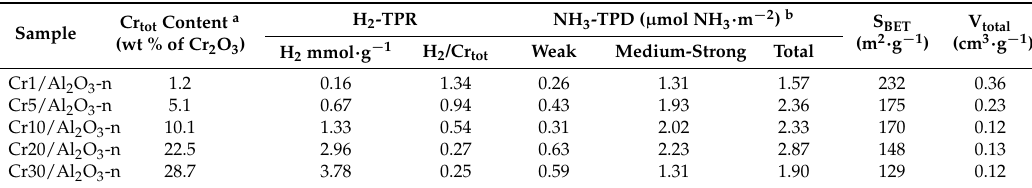
Table 2. Base characterization of Cr x /Al 2 O 3 -n catalysts.